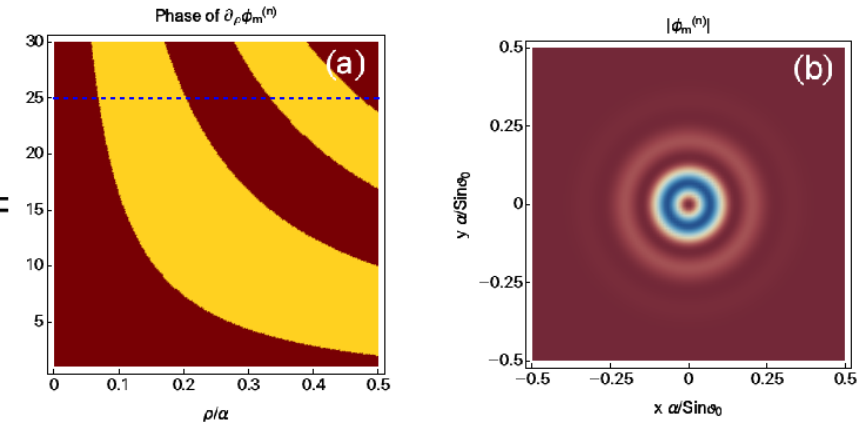
Figure 7. Example of application of the algorithm for retrieving the number of rings of a fundamental X-wave, given a specific value of n . For this specific example, we used n = 25. Panel ( a ) depicts the ( n ) { ∂ ρ φ ( n ) } = 0, phase of the radial derivative ∂ ρ φ m . The red areas correspond to regions where Arg m ( n ) } = π . Once a value of n is chosen while the yellow areas correspond to regions where Arg { ∂ ρ φ m (blue, dashed line, representing n = 25 in this case), by counting the number of times red regions cross the line of the constant n (blue, dashed line in panel ( a )), we can retrieve the number of rings ( n ) | 2 in a given radial interval, which in this case is ρ ∈ [ 0,0.5 ] . As can be seen, while possessed by | φ m in panel ( a ) we count three full crossing of the blue line with red areas, we also see, in panel ( b ), that ( 25 | 2 possesses three rings, which the transverse correspondent transverse distribution of intensity | φ 1 amounts to one ring because of the m = 1 units of OAM carried by the pulse, plus two extra rings deriving from the spectral structure of the pulse